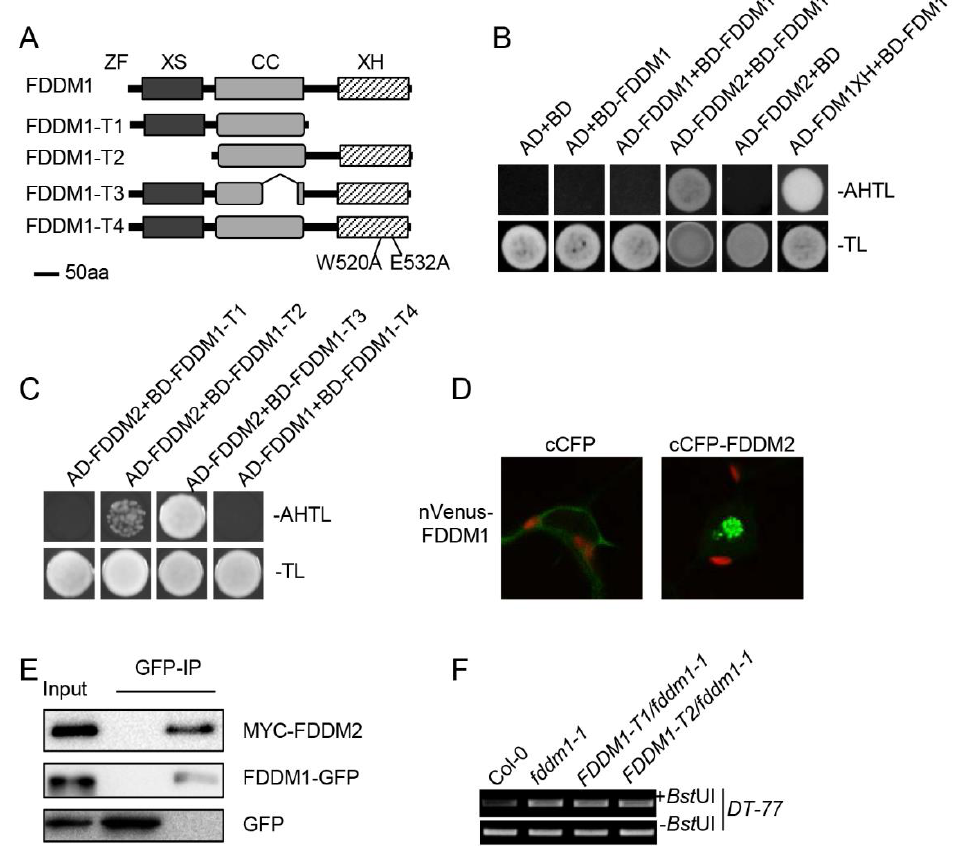
Figure 3. FDDM1 and FDDM2 act in DNA demethylation via forming a heterodimer. ( A ) The schematic structure of the truncated FDDM1 proteins. ( B ) FDDM1 interacts with FDDM2. Protein– protein interaction enables the growth of yeast cells on an adenine-deficient medium (–Ade–Leu– Trp). The interaction between FDM1XH and FDM1 was used as the positive control. ( C ) The XH domain is required for the FDDM1–FDDM2 interaction. ( D ) A BiFC analysis to detect the FDDM1–FDDM2 interaction in tobacco leaf cells. The green color indicates the BiFC signal (originally yellow fluorescence) detected by confocal microscopy. ( E ) A co-IP analysis to detect the FDDM1–FDDM2 interaction. MYC-FDDM2 co-expressed with FDDM1-GFP or GFP in tobacco leaves. IP was performed with anti-GFP antibodies, and the proteins were detected with the antibodies against MYC or GFP. ( F ) The XS and XH domains of FDDM1 are required for DNA demethylation. The restriction of enzyme-digested and undigested (loading control) DNAs were used as templates for the PCR amplification of DT-77 .